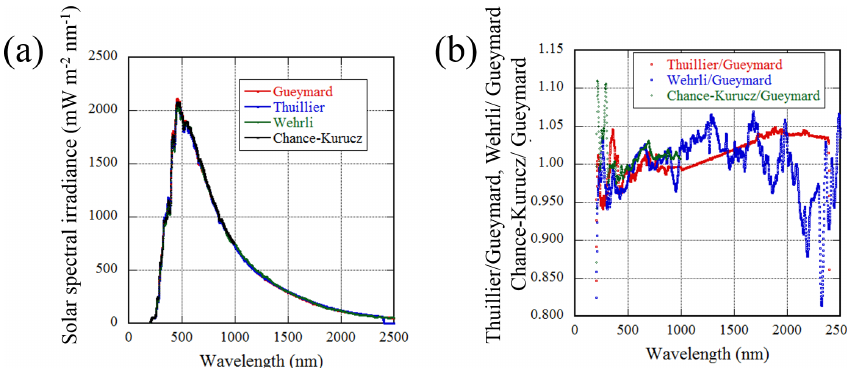
Figure 10. (a) Extraterrestrial solar spectra. The value is a mean value weighted by the response function of a triangle with FWHM of 10nm. The red line is Gueymard (2004), the blue line is Thuillier et al. (2003), the green line is Wehrli (1985), and black line is Chance and Kurucz (2010). (b) Ratios of the solar spectrum to Gueymard (2004).